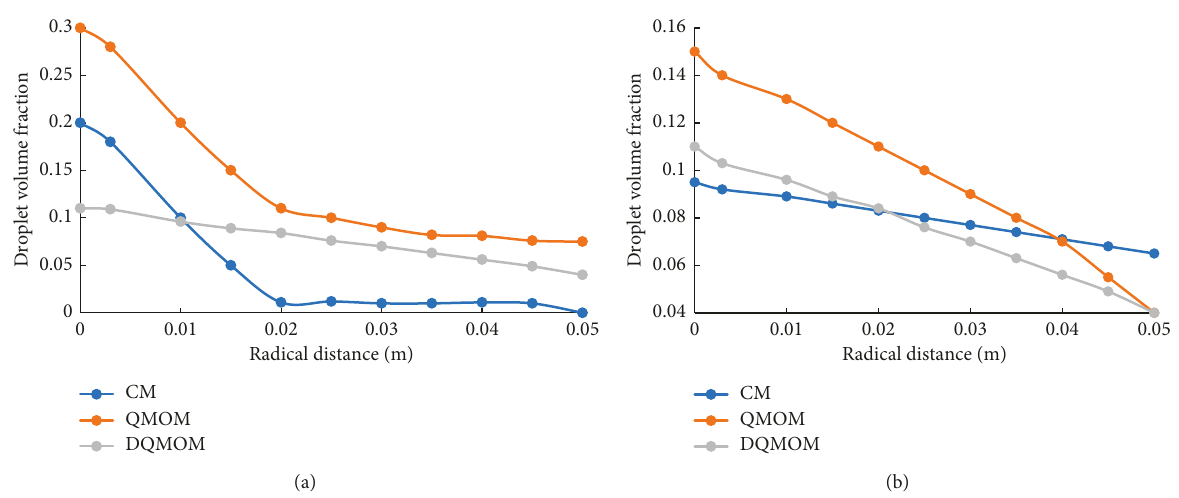
Figure 11: The disperse phase volume along the radical direction at (a) h � 0.09m and (b) h � 0.2m in the